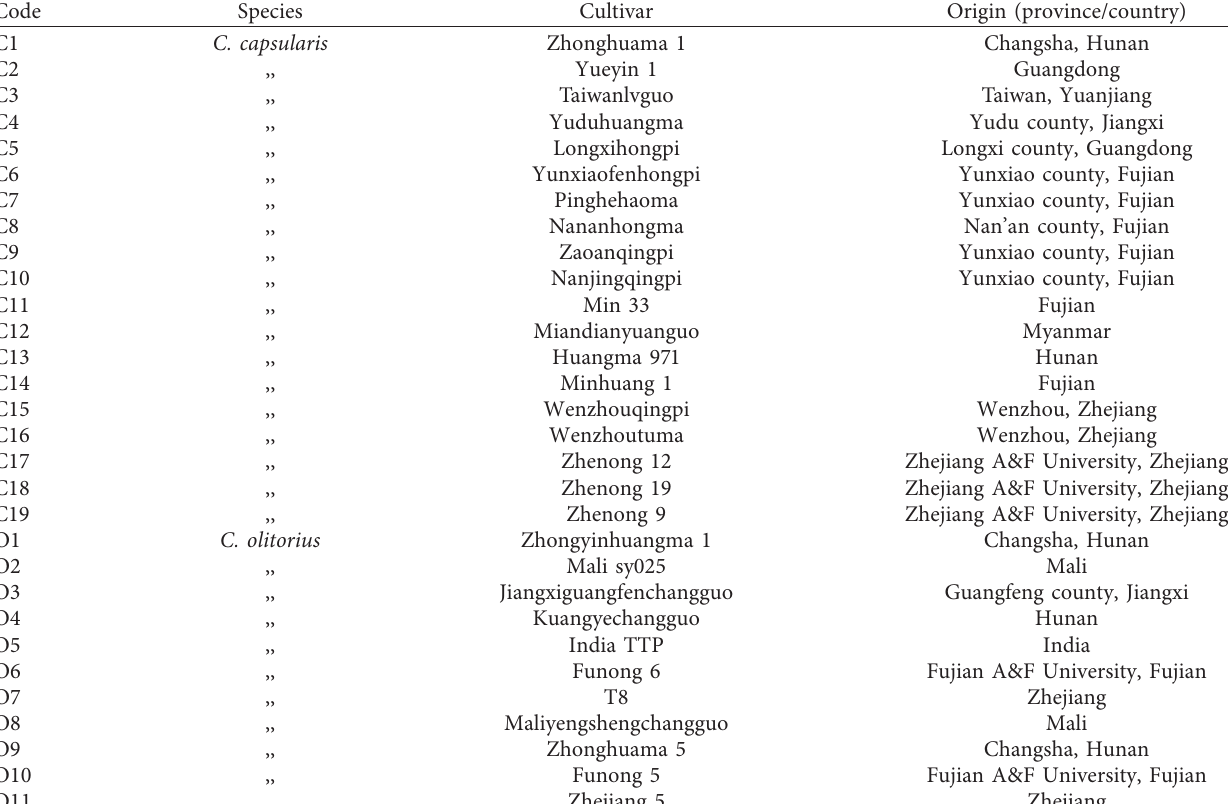
Table 1: Origin of 30 different genotypes of C. capsularis and C. olitorius .